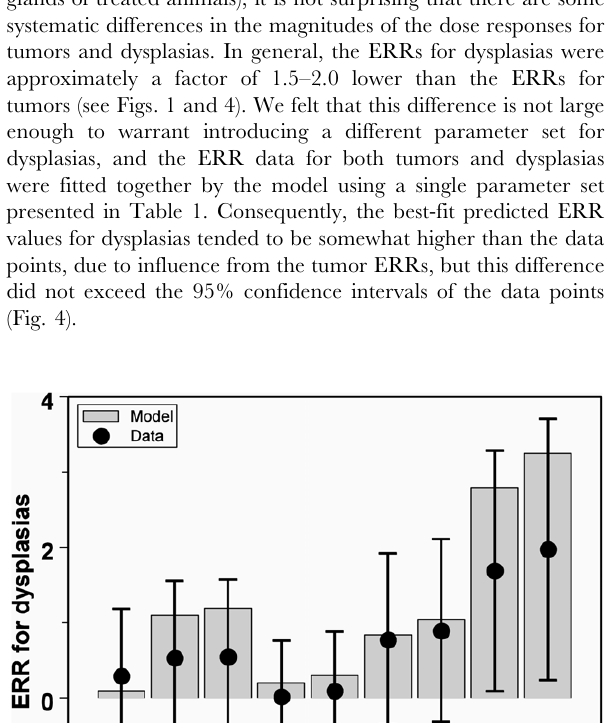
Figure 3. Frequencies of ductal mammary dysplasias observed in the fat pads of untreated mice after transplant of mammary epithelial cells from carcinogen-treated mice. 1=control group, 2=treated with 2.5 m g DMBA, 3=0.25 Gy c -rays at high dose rate, 4=2.5 m g DMBA + 0.25 Gy c -rays at high dose rate, 5=0.25 Gy c -rays at low dose rate, 6=2.5 m g DMBA + 0.25 Gy c -rays at low dose rate, 7=0.025 Gy neutrons at high dose rate, 8=2.5 m g DMBA + 0.025 Gy neutrons at high dose rate, 9=0.025 Gy neutrons at low dose rate, 10=2.5 m g DMBA + 0.025 Gy neutrons at low dose rate. Filled bars=to- tal dysplasias (measured 10 weeks after transplant), empty bars=per- sistent dysplasias (those visible 16 weeks after transplant). Details are discussed in the main text.